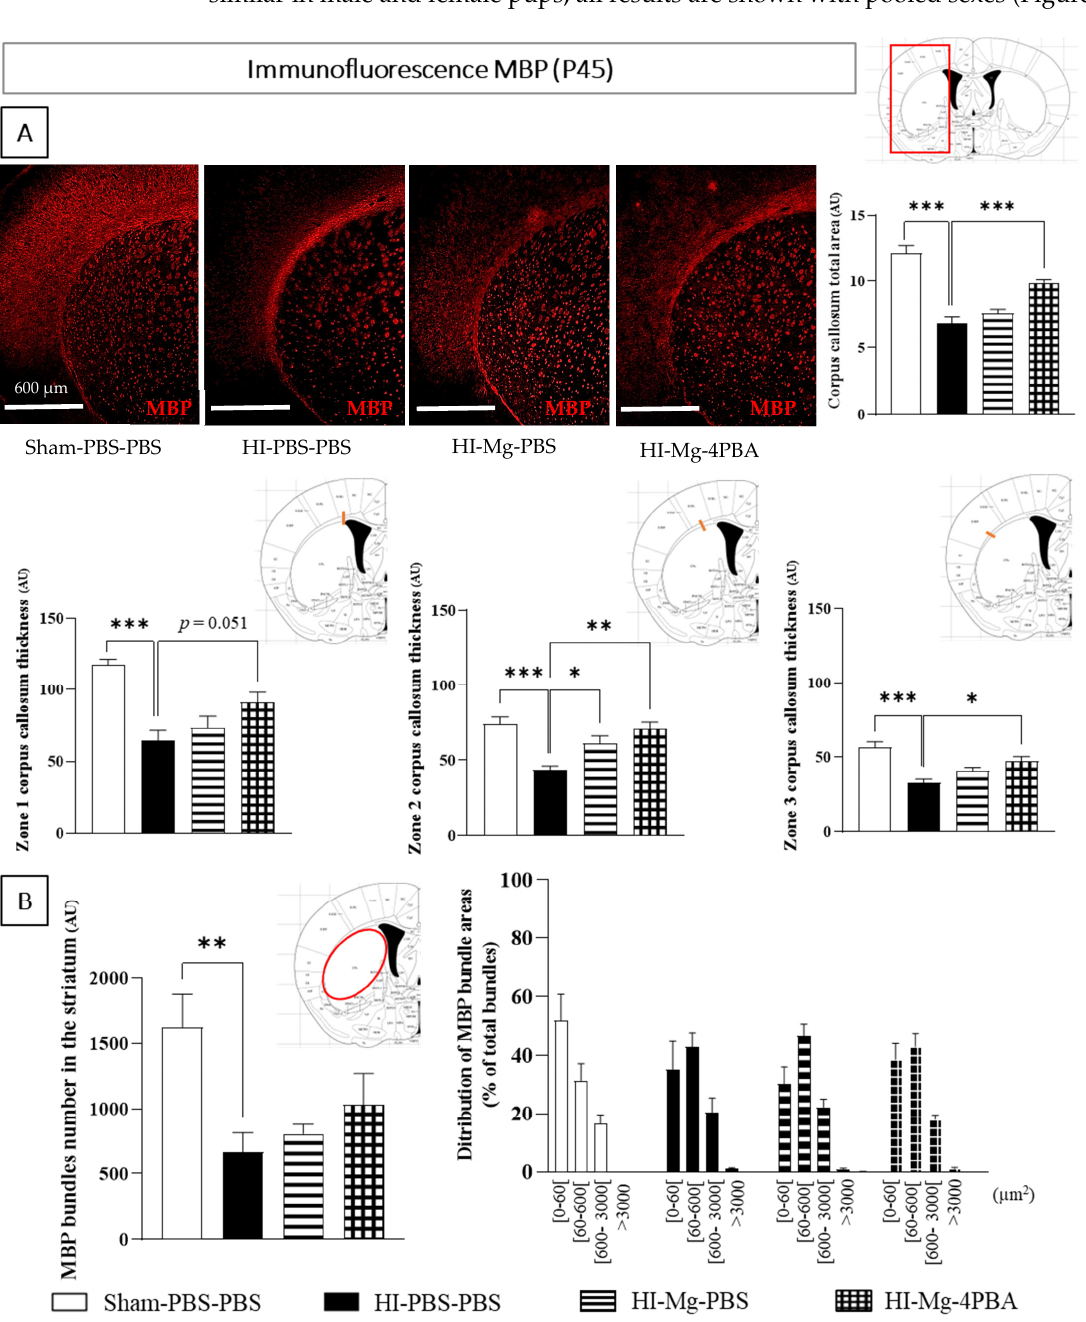
Figure 7. Effects of neonatal HI, MgSO4 or of the MgSO4/4-PBA association on myelin integrity (MBP) in the corpus callosum and the striatum of ipsilateral hemisphere, at P45. ( A )—MBP labeling immunofluorescence and quantification of corpus callosum area and thickness in 3 zones containing axons that projects to the motor cortex (Zone 1), sensory cortex (Zone 2) and auditory cortex (Zone 3); AU: Arbitrary unit. ( B )—Quantification MBP bundles number in the striatum and distribution of bundles sizes ( µ m 2 ). Sexes are pooled. Data are expressed as M ± S.E.M, n = 5–6 pups/group. One-way ANOVA was performed followed by Tukey’s post-test (* p < 0.05, ** p < 0.01, *** p < 0.001). For bundle distribution, two-way ANOVA was performed; no significant result was